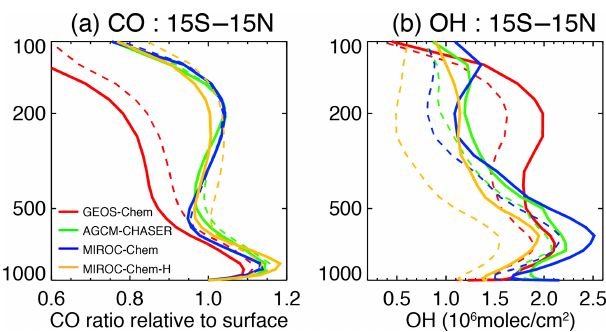
Figure 12. Vertical profiles of (a) annual mean CO concentrations and (b) annual mean OH concentrations averaged between 15 ◦ S and 15 ◦ N, obtained from the control runs (dotted lines) and data assimilation analysis (solid line). For CO (a) , the relative ratio to the mean surface concentrations is shown. For OH (b) , the unit is 10 6 moleculescm − 3